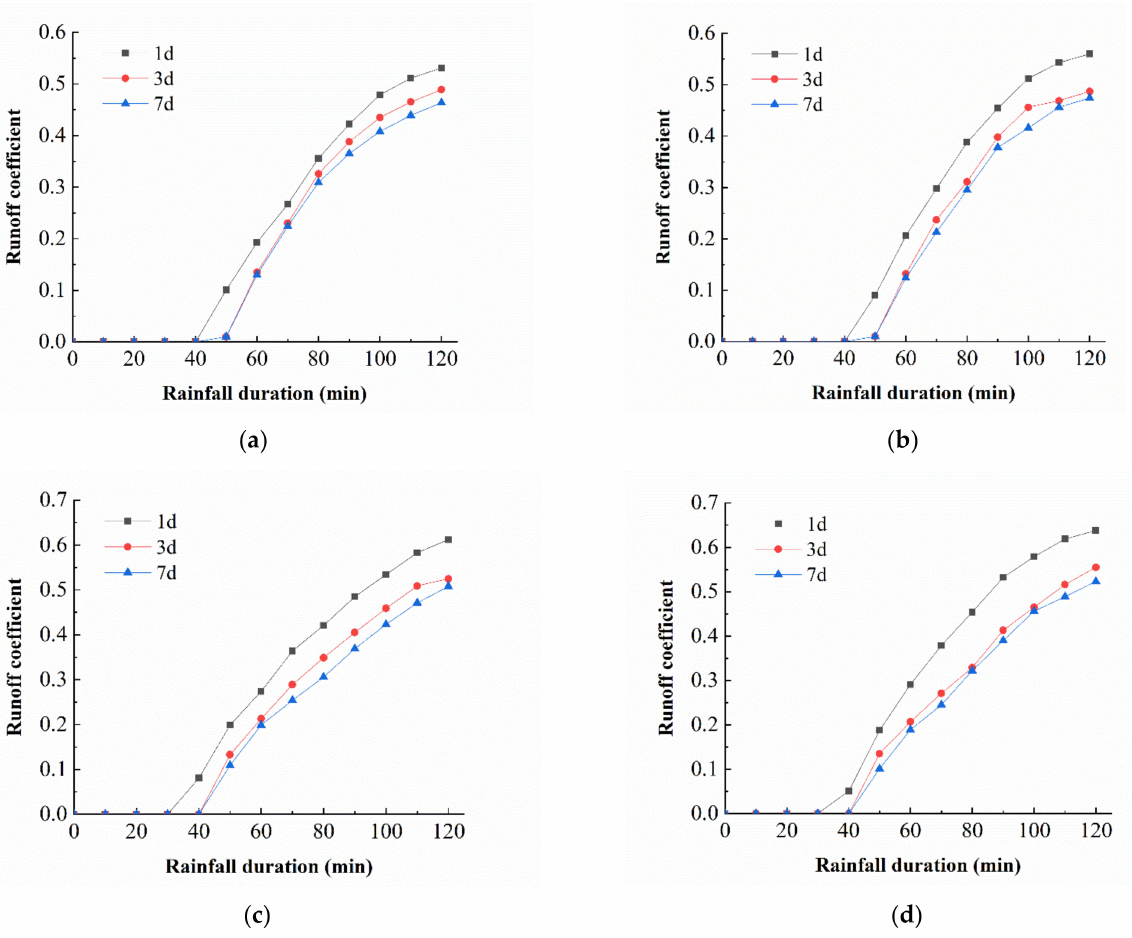
Figure 6. Runoff coefficient of each permeable pavement under different rainfall intervals; ( a ) type I; ( b ) type II; ( c ) type III; and ( d ) type